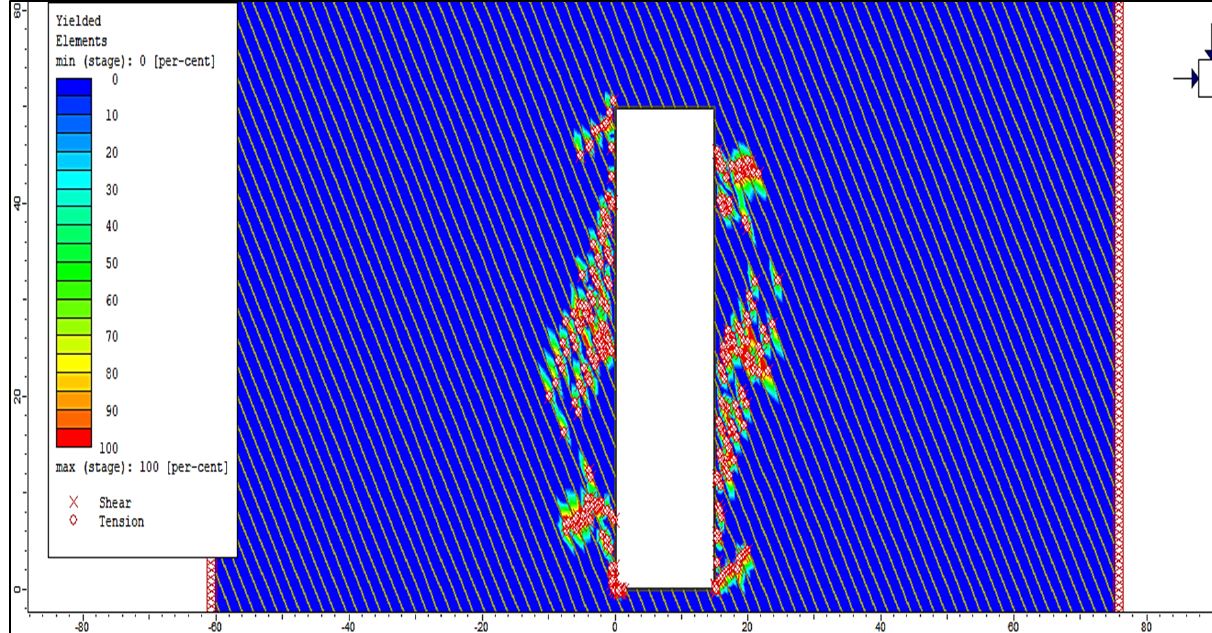
Figure 6. Case study #12: “Yielded Elements” distribution. Table 6. Case study #12: Stability parameters and final results.